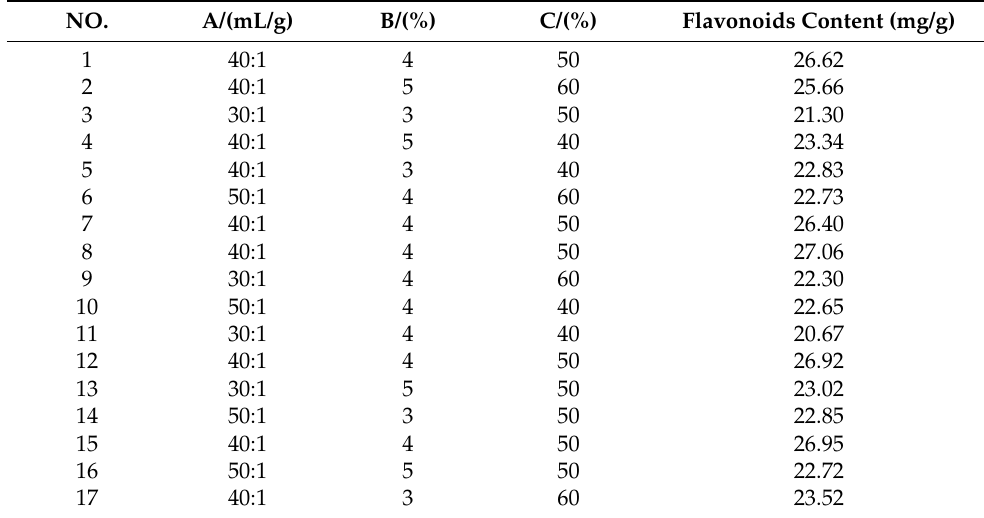
Table 1. Scheme and experimental results of Box–Behnken.